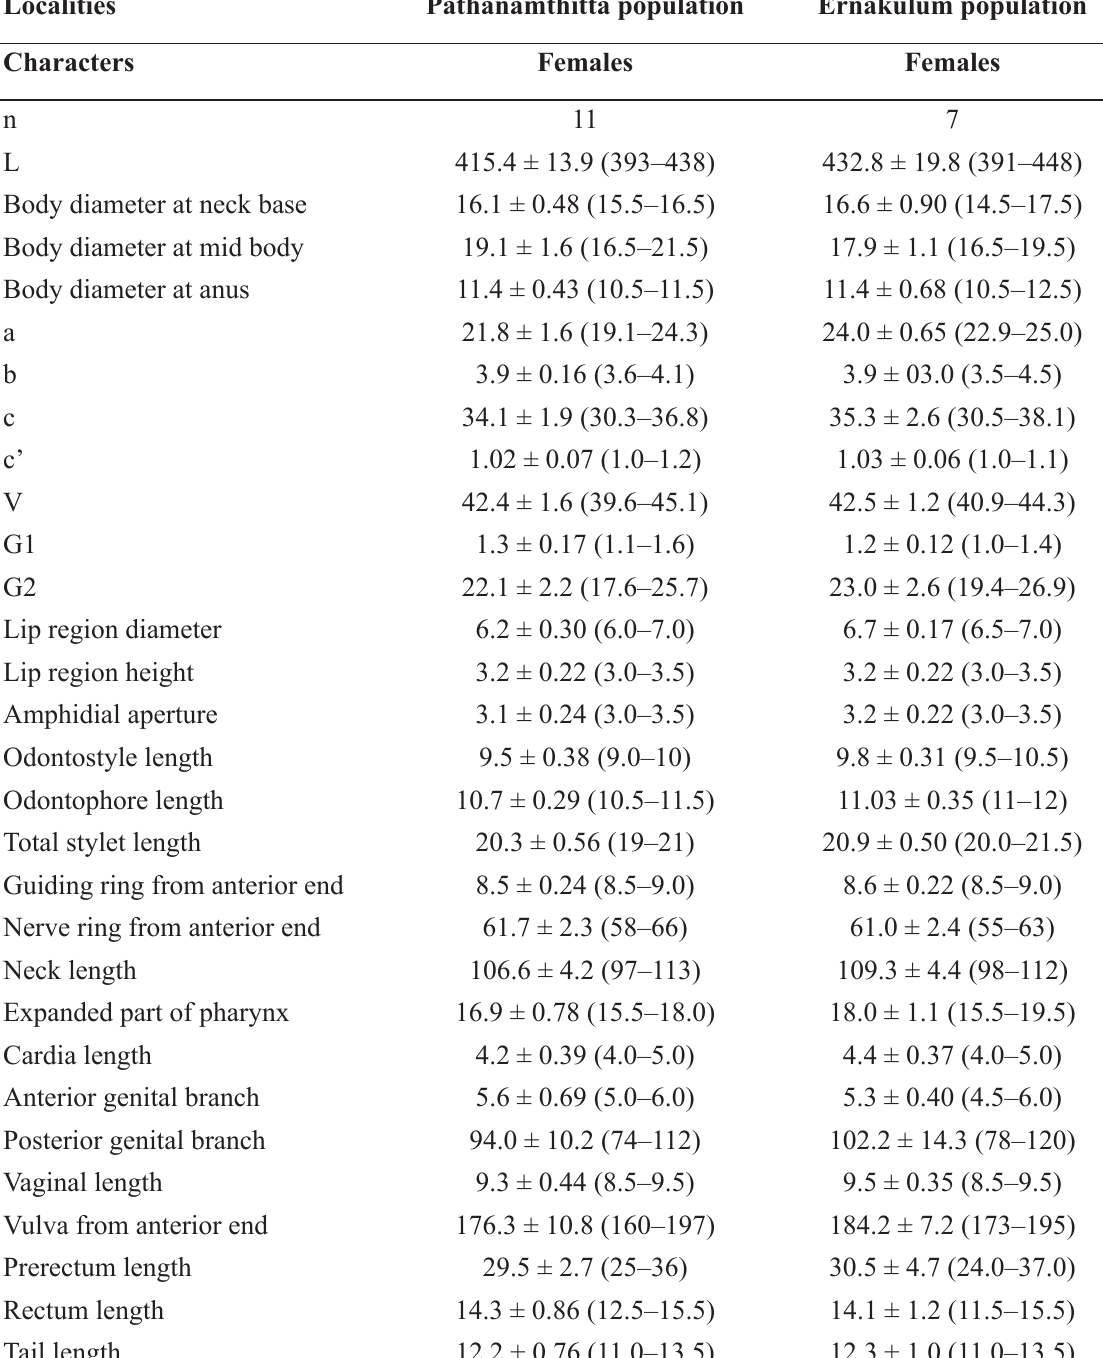
Table 3. Measurements of Basirotyleptus nindei Siddiqi, 1970. All measurements are in μm and in the form: mean ± s.d.